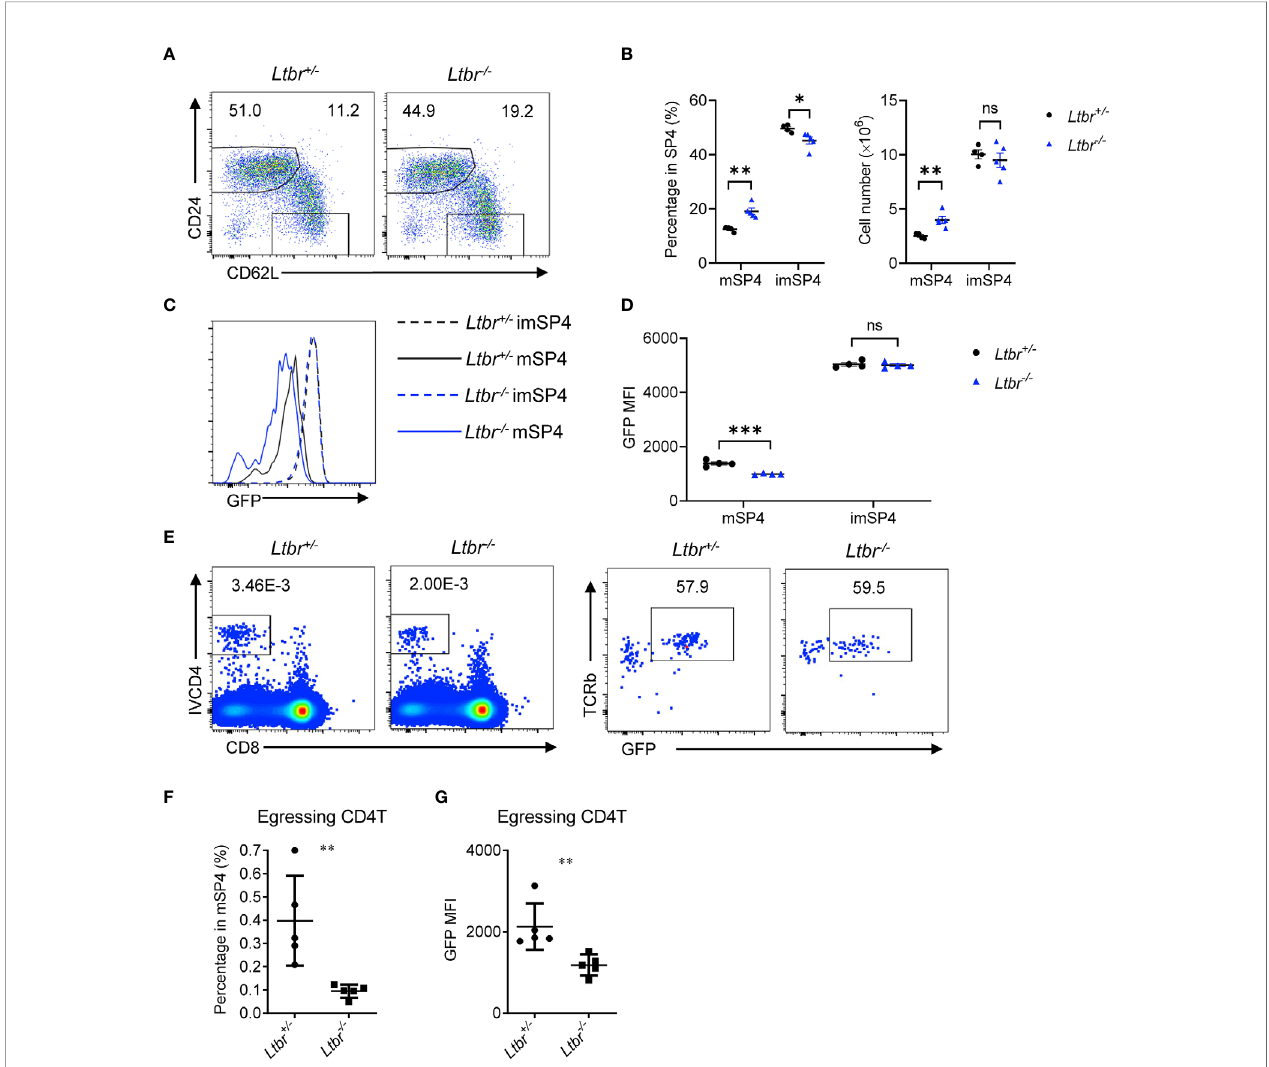
FIGURE 1 | LT b R regulates thymic egress. (A, B) Flow cytometric analysis of single-positive (SP) CD4 + (SP4) thymocytes in Ltbr − / − and littermate control mice. (A) Representative dot plots are shown. (B) The graphs display the statistical analysis of the percentage of immature (imSP4) or mature (mSP4) thymocytes among total SP4 population. Mean ± SEM; n = 4 and 5. Data are representative of at least three independent experiments. (C, D) Flow cytometric analysis of GFP expression on SP4 thymocytes in Ltbr − / − Rag2pGFP and littermate control mice. (C) Representative histogram plots are shown. (D) The graphs display the statistical analysis of the GFP mean fl uorescence intensity (MFI) of populations in (C) Mean ± SEM; n = 4. Data are representative of at least three independent experiments. (E, F) Flow cytometric analysis of IVCD4-labeled GFP + thymocytes in Ltbr − / − and littermate control mice. (E) Representative dot plots are shown. (F) The graphs display the statistical analysis of the percentage of IVCD4-labeled GFP + thymocytes among total mSP4. (G) Flow cytometric analysis of GFP expression on IVCD4- labeled GFP + thymocytes in Ltbr − / − Rag2pGFP and littermate control mice. The graphs display the statistical analysis of GFP MFI of egressing CD4 + T cells. Mean ± SEM; n = 5. Data are representative of at least three independent experiments. ns, P > 0.05; *P < 0.05; **P < 0.01; ***P < 0.001 (unpaired Student ’ s t